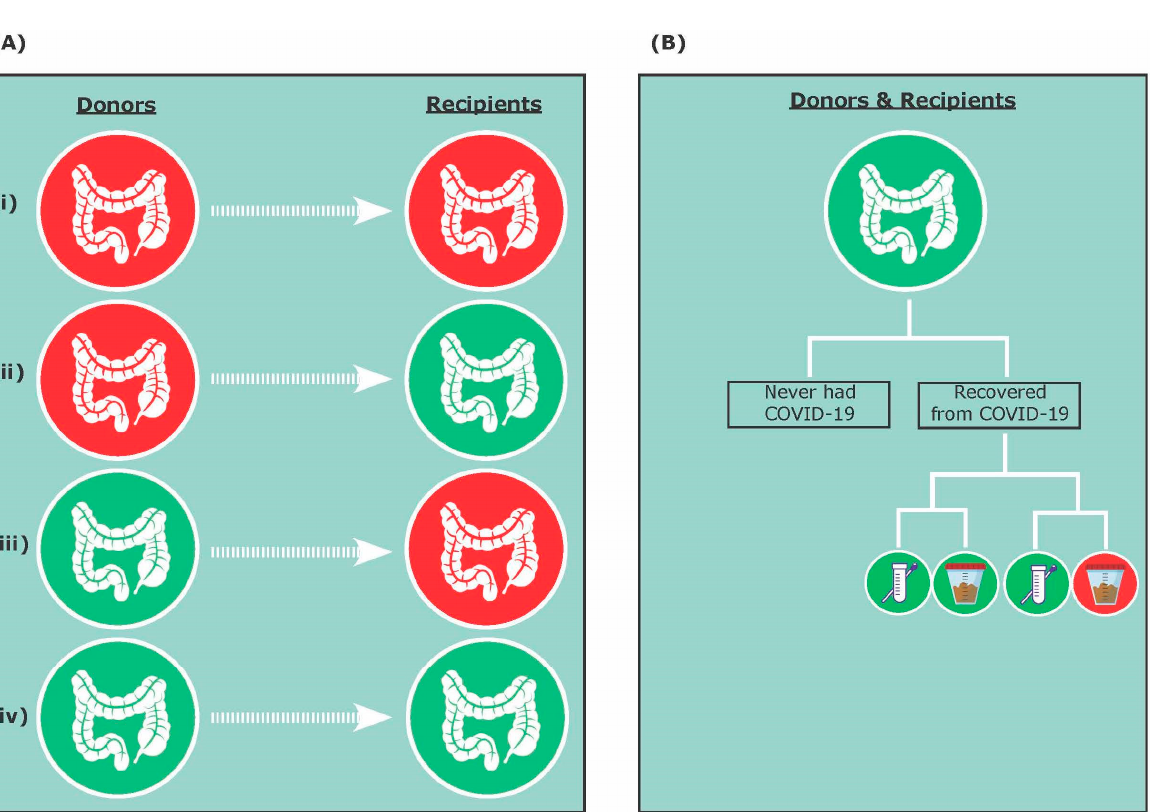
Figure 1. Fecal microbiota transplantation (FMT) treatment during COVID-19 and post-COVID-19 pandemic. ( A ) The four possible FMT donor and recipient combinations include: ( i ) asymptomatic COVID-19 donor and asymptomatic COVID-19 recipient; ( ii ) asymptomatic COVID-19 donor and COVID-19-negative recipient; ( iii ) COVID-19-negative donor and asymptomatic COVID-19 recipient; and ( iv ) COVID-19-negative donor and COVID-19-negative recipient. ( B ) Donors and recipients that have tested negative for COVID-19 could have never had COVID-19 or have recovered from COVID-19. Recovering donors and recipients could have a negative nasopharyngeal test and a negative stool test, or a negative nasopharyngeal test and a positive stool test.